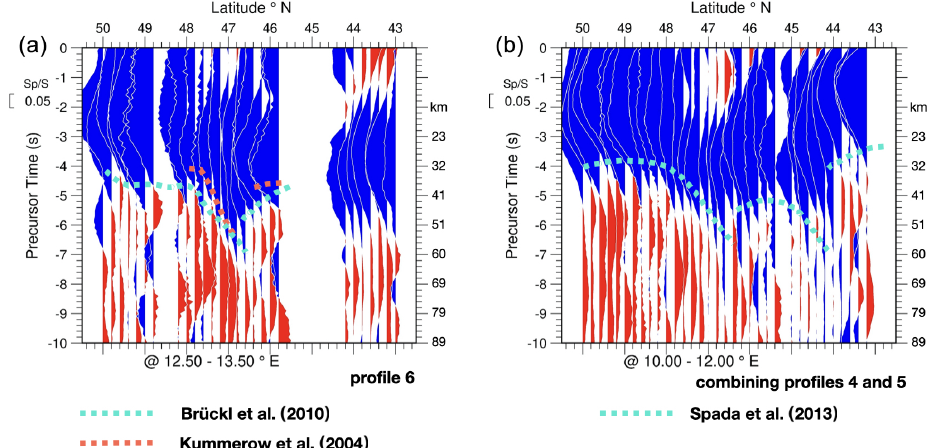
Figure 18. Copies of north–south profiles with results of earlier studies for comparison. (a) Comparison of profile 6 (Fig. 8a) with Brückl et al. (2010; their Fig. 3a), who used Moho data of Behm et al. (2007) based on wide-angle reflection and refraction data, and, with Kummerow et al. (2004) using the P-receiver function method. (b) Comparison of a combination of the corridors of profiles 4 and 5 (Figs. 6a and 7a) with the same profile taken from map of Spada et al.